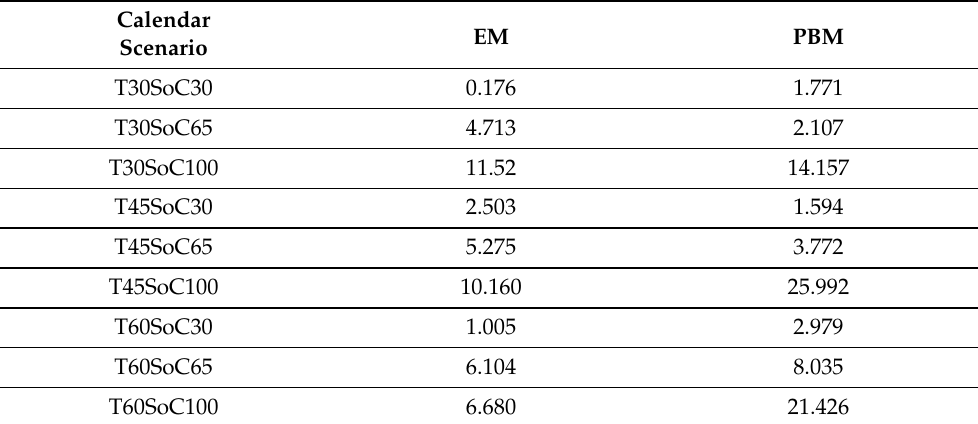
Table 3. Mean absolute error for capacity fade in calendar aging with all models (expressed in %).